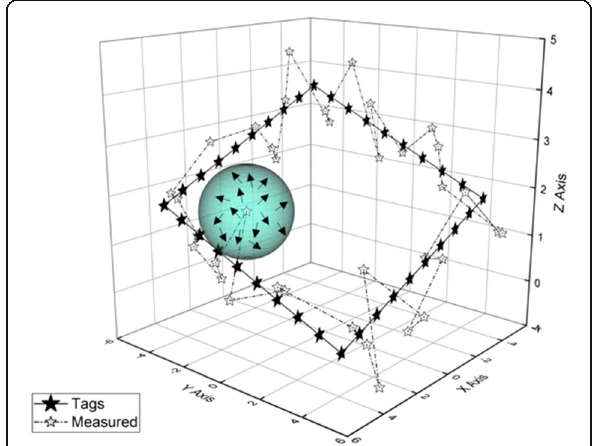
Fig. 8. All the positions of targets are supposed uniform distribution; we test 36 targets in this paper.